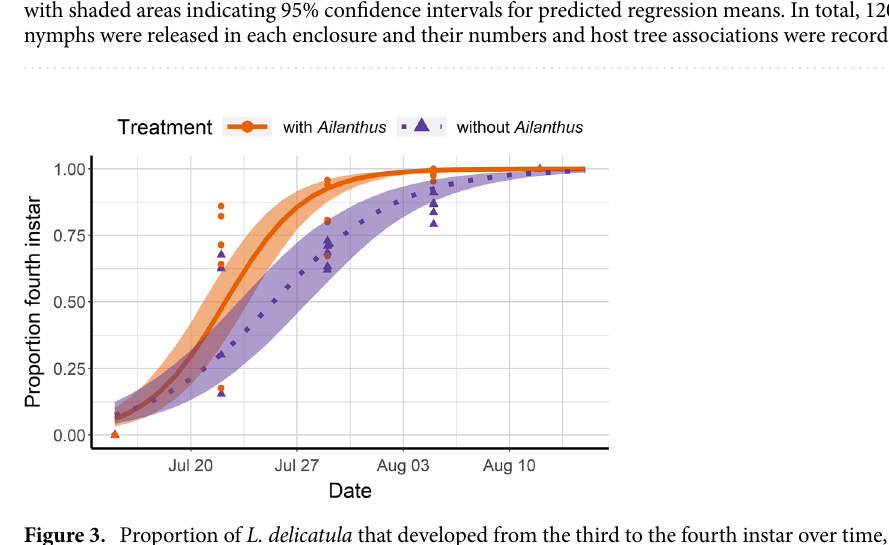
Figure 3. Proportion of L. delicatula that developed from the third to the fourth instar over time, with fitted logistic regression lines, in enclosures with and without Ailanthus altissima